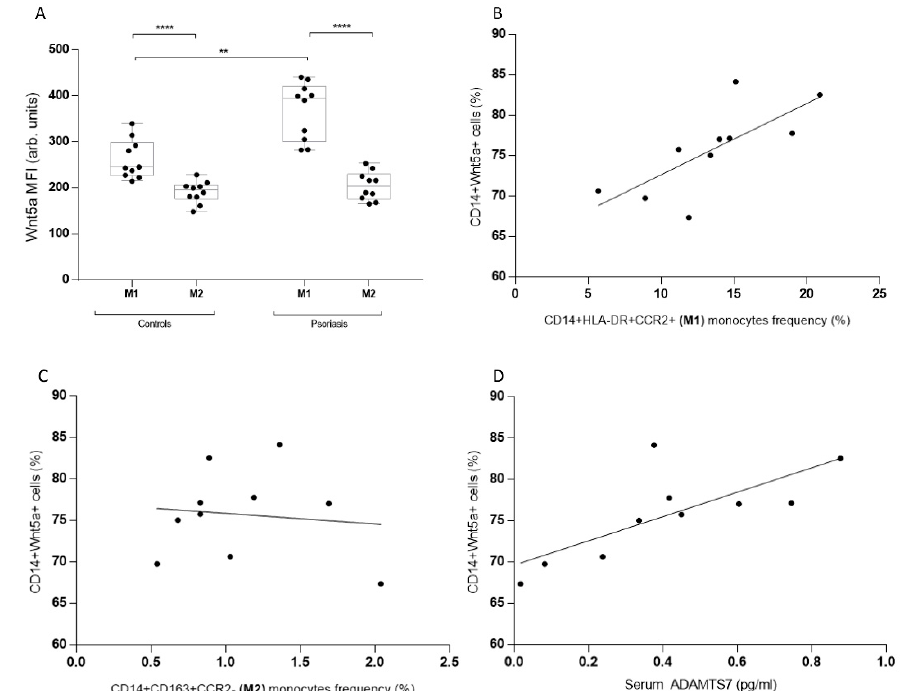
Figure 2. Monocyte phenotype and cardiovascular risk marker (ADAMTS7) correlations with Wnt5a levels in psoriatic and healthy subjects. ( A ) Levels of intracellular Wnt5a in M1 and M2 monocytes from healthy subjects and psoriatic patients. ( B ) CD14+Wnt5a+ cells and M1 monocytes frequency correlation in psoriatic patients. ( C ) CD14+Wnt5a+ cells and M2 monocytes frequency correlation in psoriatic patients. ( D ) CD14+Wnt5a+ cells and serum ADAMTS7 levels in psoriatic patients. ( A ) **** p = 0.0002, ** p = 0.0018; ( B ) r = 0.74, p = 0.015; ( C ) r = − 0.11, p = 0.76; and ( D ) r = 0.75, p = 0.012. A Mann–Whitney and Spearman’s rank correlation coefficient test were both used.